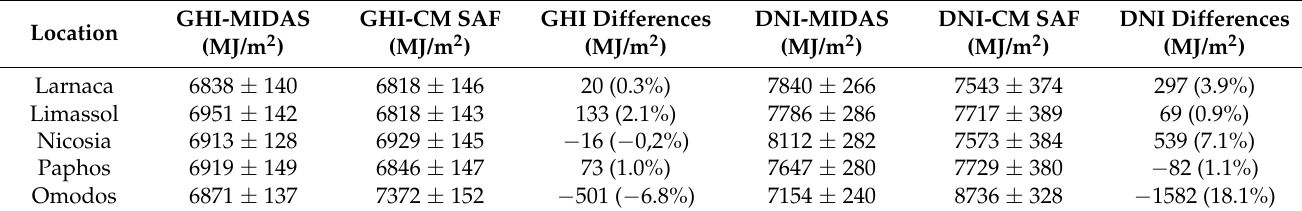
Table 5. GHI and DNI simulated using MIDAS AOD, and from CM